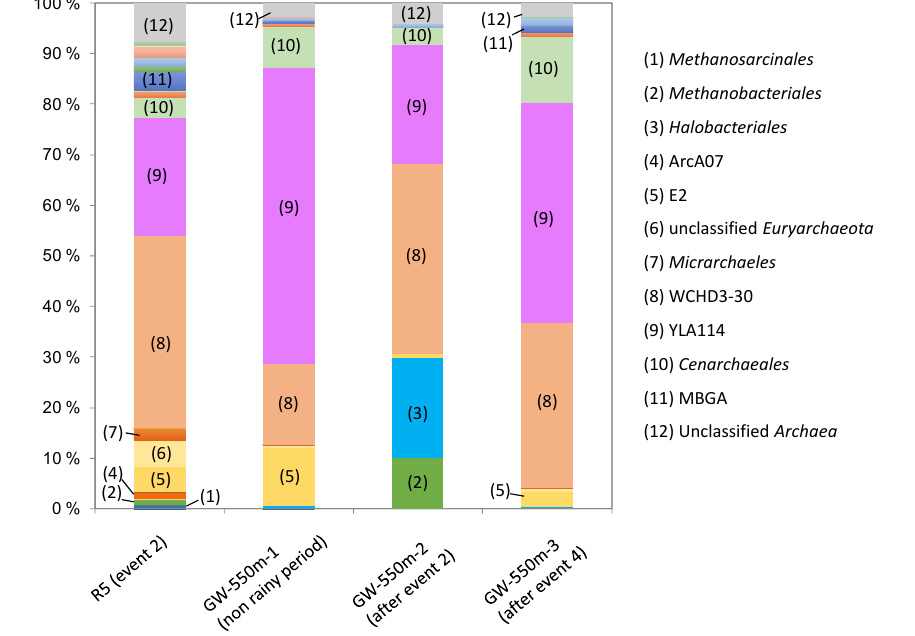
Figure 5. Relative abundance of archaeal orders in each event by next-generation sequencing